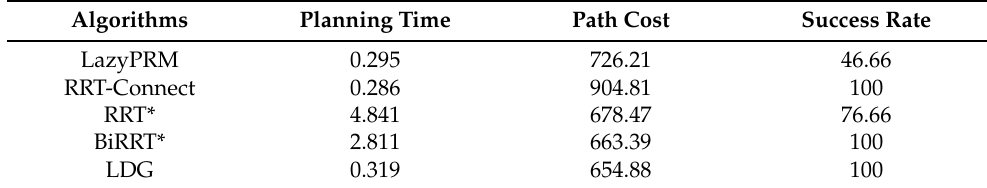
Table 2. Speed, path cost and success rate of LDG benchmarked against other algorithms in scene 2.